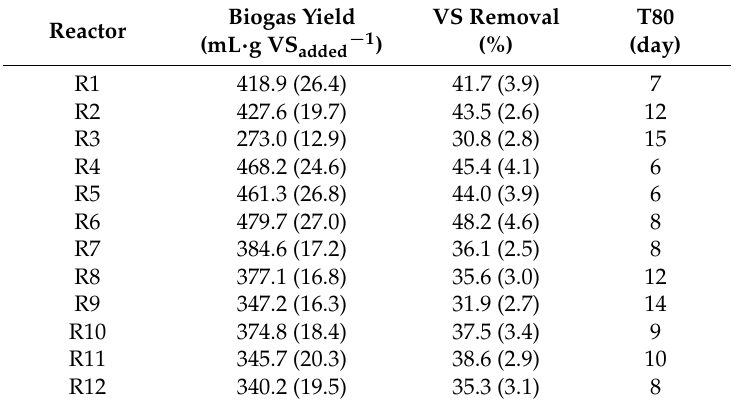
Table 3. Biogas yield, volatile solids (VS) removal, and technical digestion time for all the reactors.